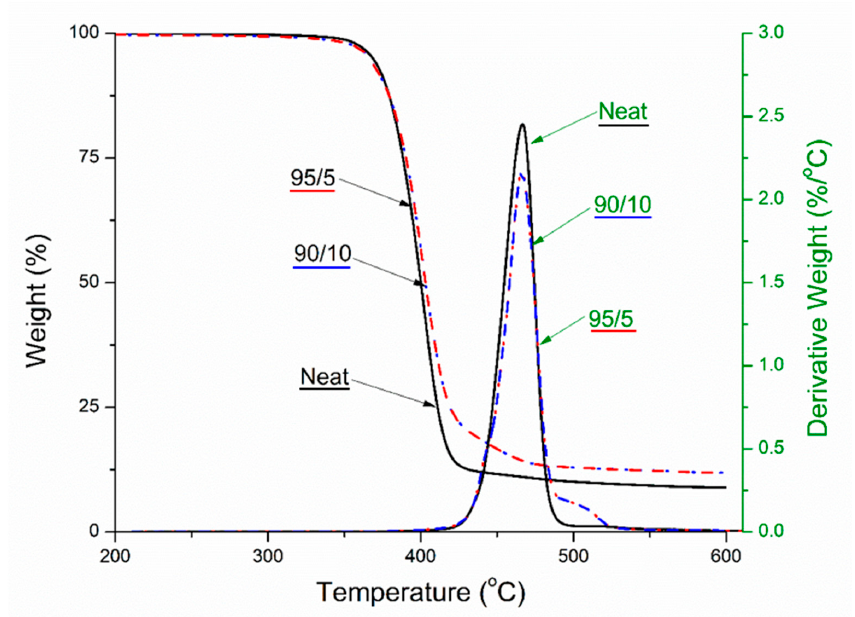
Figure 3. Thermogravimetric analysis (TGA) curves (weight and derivative weight) of the PTT blends and its biocomposites. See Table 2 for